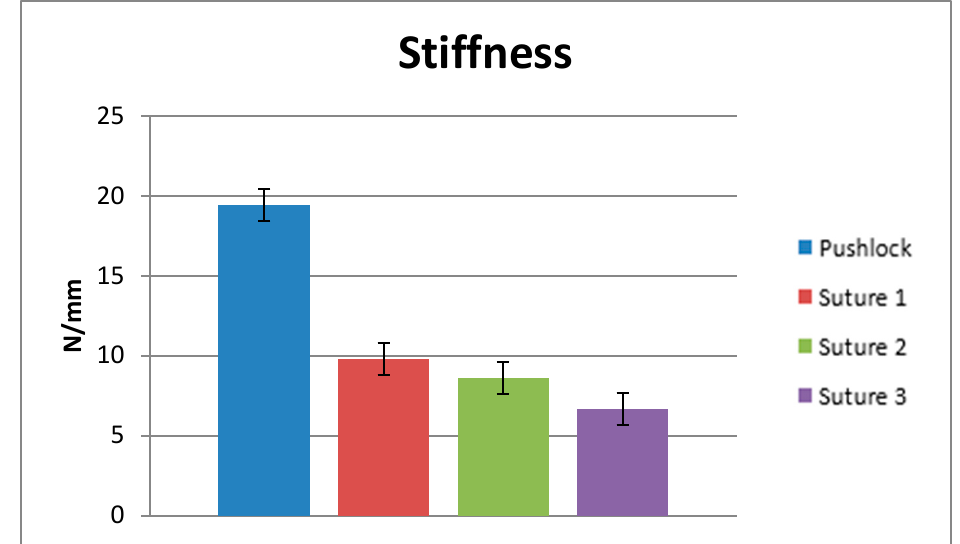
Figure 5. Stiffness.